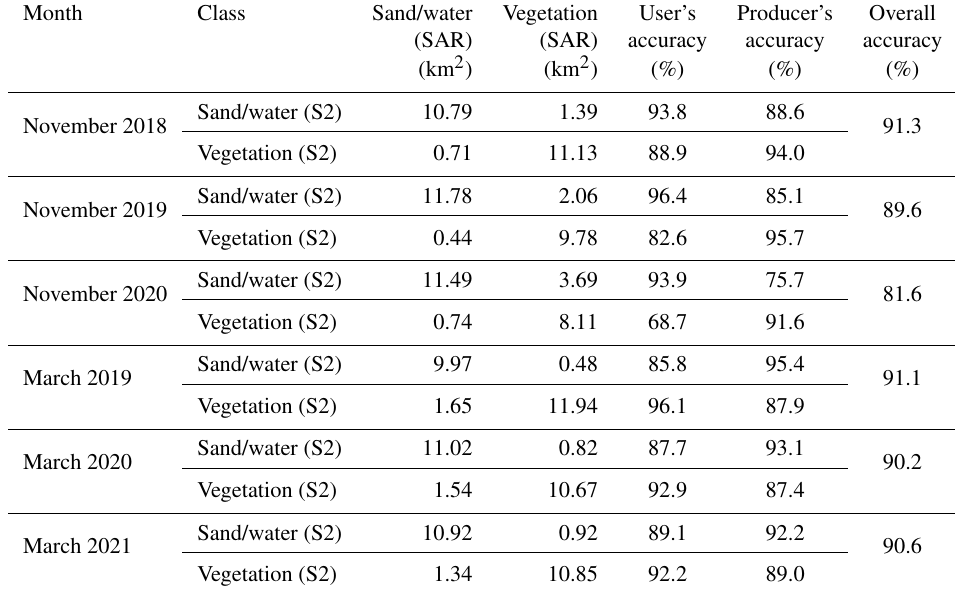
Table B6. Confusion matrix of resultant land cover classification as obtained from SAR versus Sentinel-2 (S2) for 6 different